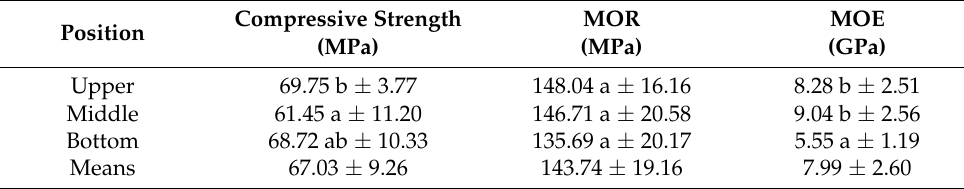
Table 5. Mechanical properties of the culm wall at different height in T. oliveri .